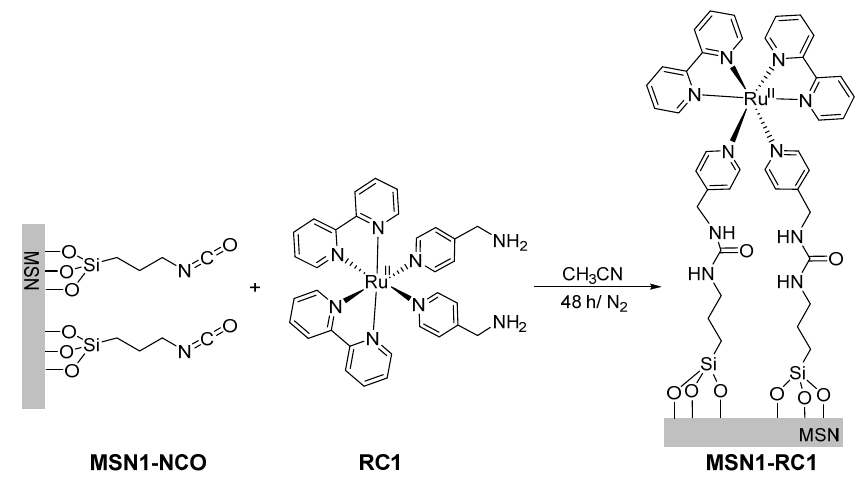
Figure 1. Preparation of MSN1-RC1 by grafting RC1 onto the mesoporous surface of MSN1-NCO .